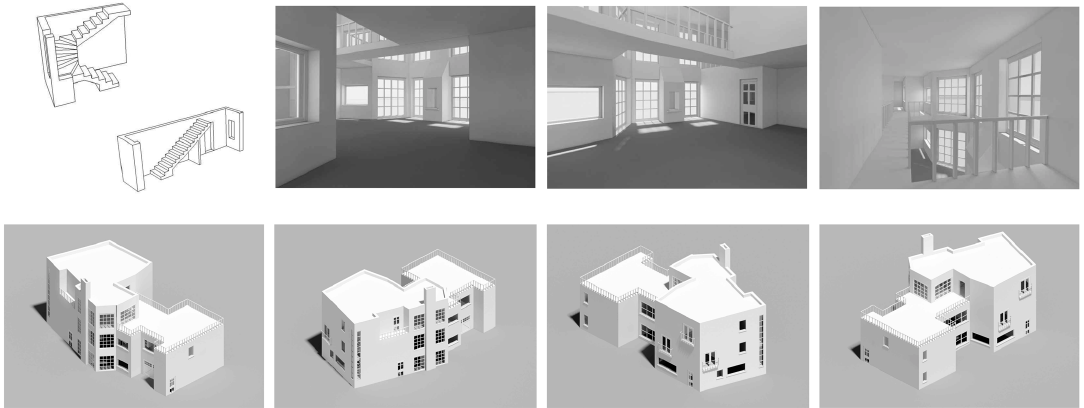
Figure 13. House 11. Schemes, axonometric views, perspectives (C.